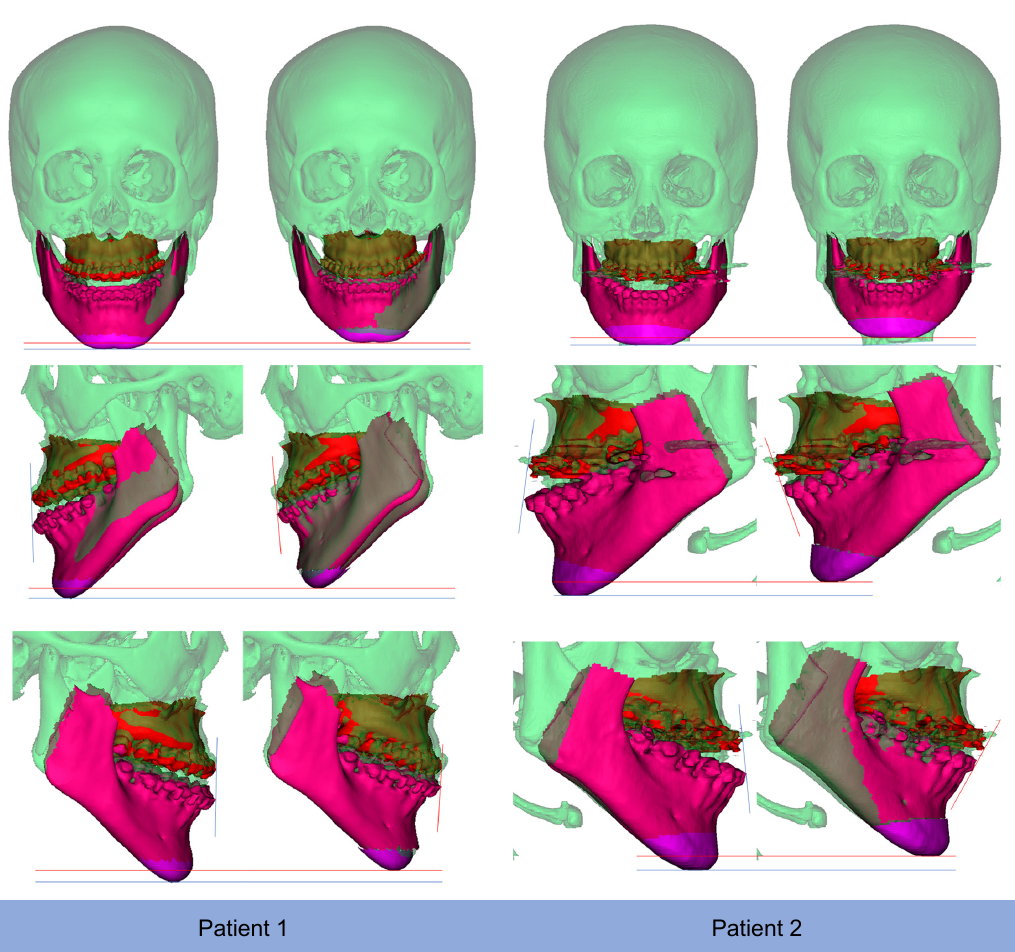
Figure 4. Pre-operative ( left ) and post-operative ( right ) surgery prediction through the alignment network of two randomly selected patients. Table 4. Mean absolute error of transformation parameters using pointnet++ as feature extractor and distance error loss for training. Note that y 1– y 6 are the six rigid transformation parameters de- fined by axis and angle.